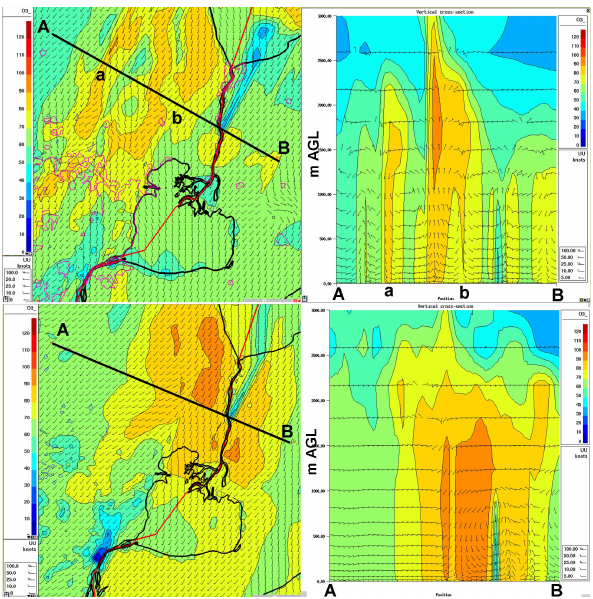
Fig. 8. Model-predicted fields for 26 June. 18:00 UT (02:00p.m. local time): (a) Surface ozone and wind barbs; (b) vertical profile of ozone and winds along cross-section A–B. (c, d) : as in (a, b), but at 23:00 UT (07:00p.m. local time).